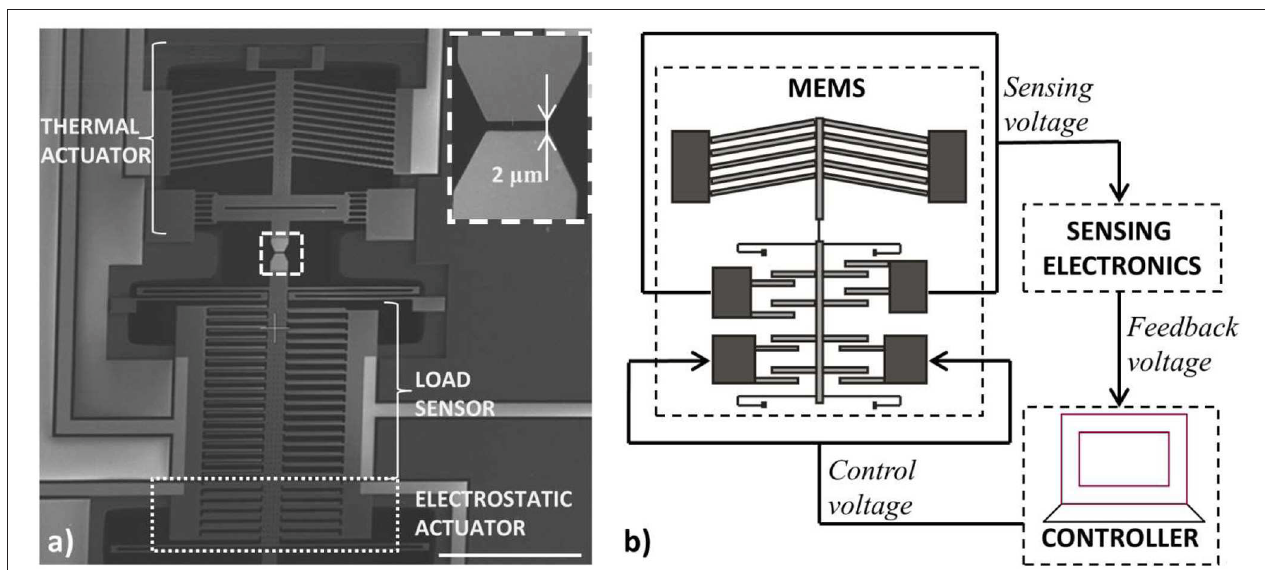
FIGURE 2 | (a) SEM picture of the tensile testing device proposed in Pantano et al. (2015) provided with load sensor feedback control. It consists of a thermal actuator, a capacitive load sensor, and an electrostatic actuator. The thermal actuator and the load sensor are separated by a 2 µ m gap for accommodation of the sample to be tested (zoomed view on top); (b) Implementation of the feedback voltage control scheme for keeping the load sensor at rest during test on a sample. Scale bar: 500 µ m.